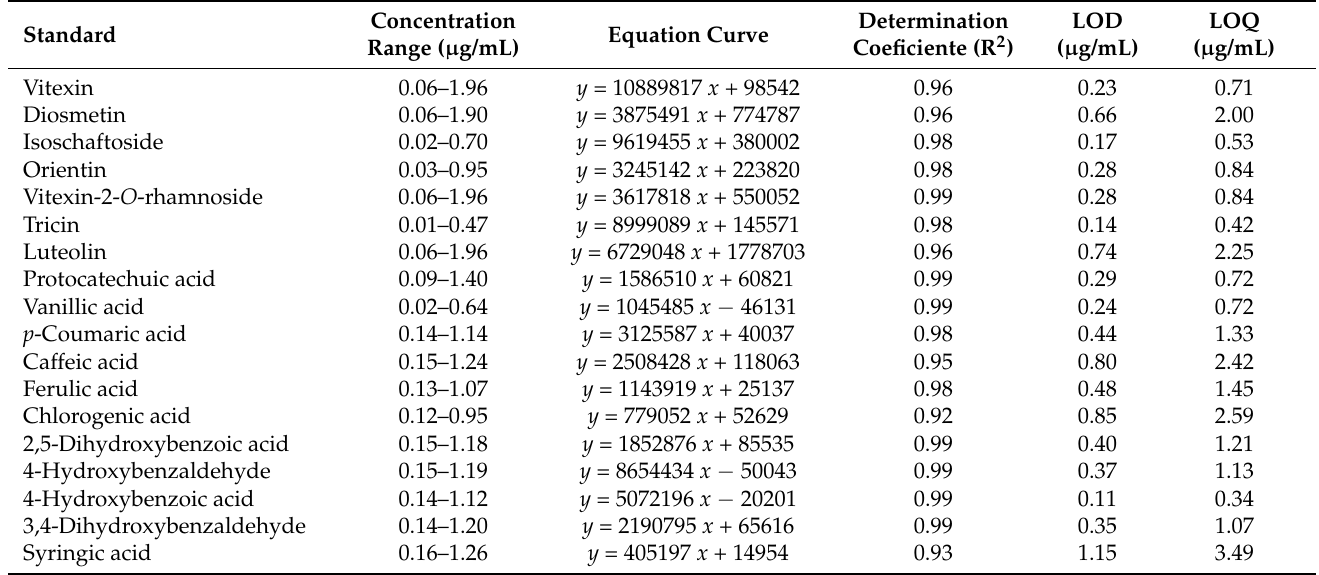
Table 2. Parameters of calibration curves used for sugarcane straw phenolic compound quantification through